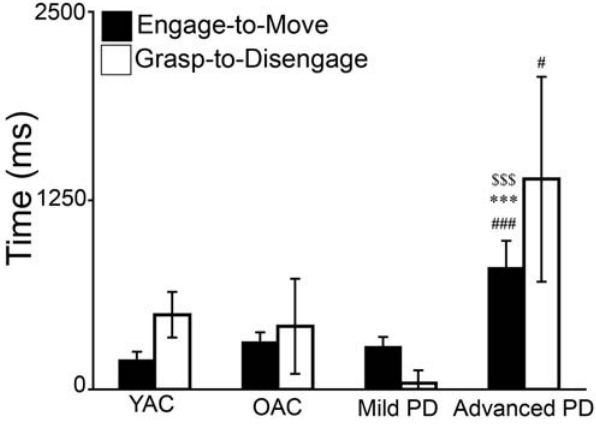
Figure 6. Time to complete advance and withdrawal (mean and standard errors) for the four experimental groups. *=different from visual condition (* , 0.05; ** , 0.01; *** , 0.001). Note for the advanced PD group both advance and withdrawal shows a significant change.